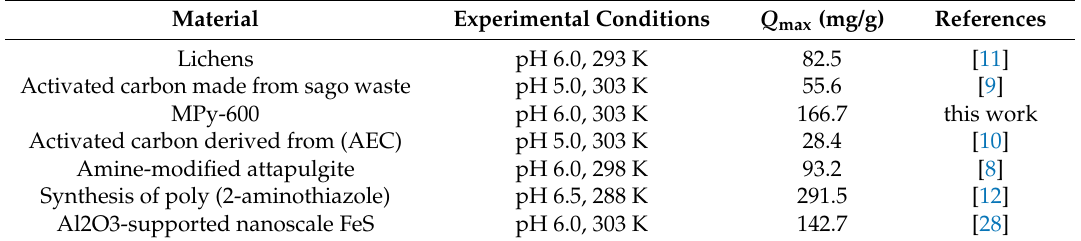
Table 2. Comparison of the maximum adsorption capacities ( Q max ) of Hg(II) on various